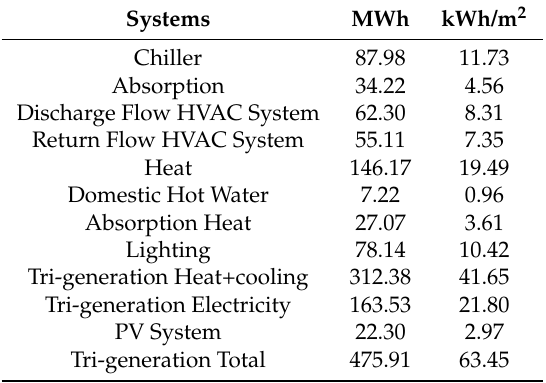
Table 1. Energy Use and generation by CHP System and PV System at LUCIA nZEB per year.